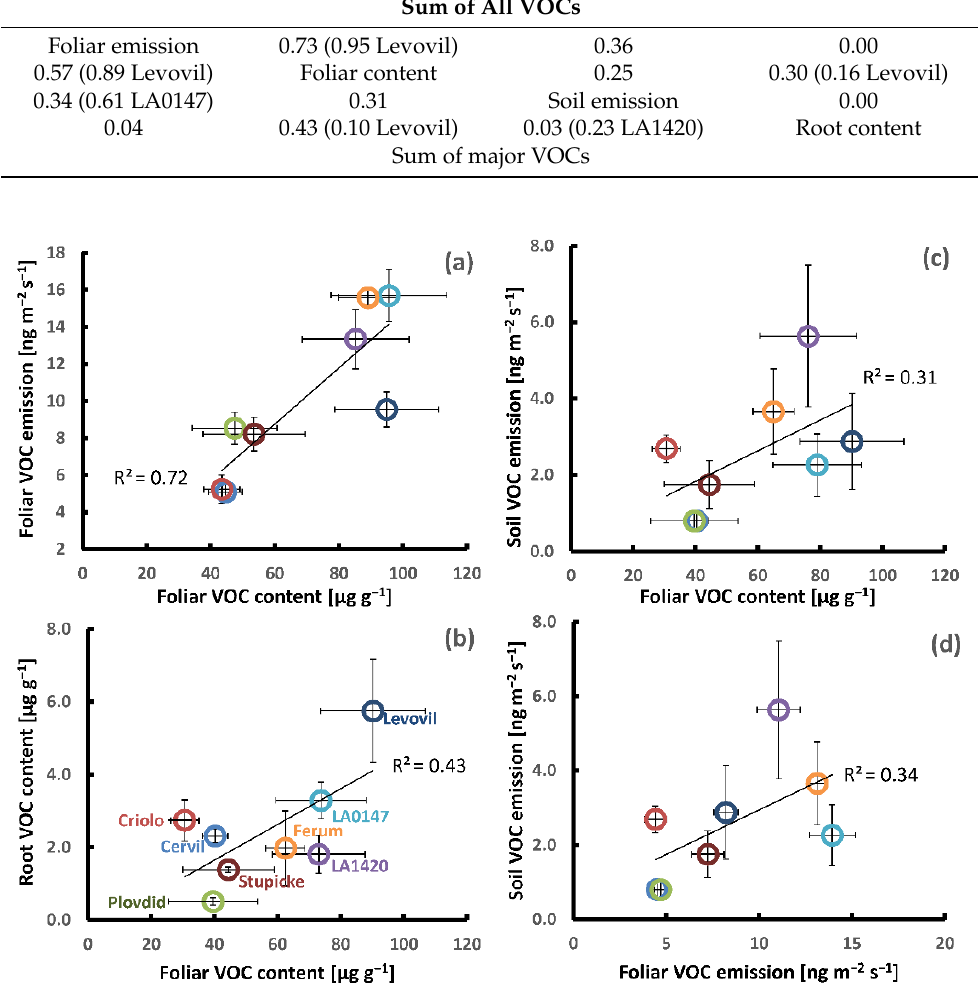
Figure 3. Examples of genotypic covariations in the aboveground and belowground VOC production of the eight parents of the MAGIC tomato population; ( a – c ): Foliar VOC contents vs. foliar VOC emissions, root VOC contents, and soil VOC emissions; and, ( d ) foliar VOC emissions vs. soil VOC emissions. The small inserted graph in ( a ) shows the foliar VOC contents vs. foliar CO 2 -assimilation. All of the data points represent the mean values per genotype ± SE of three to six plant replicates. Note that the belowground VOC production was determined on different plants than those used for the determination of aboveground VOC